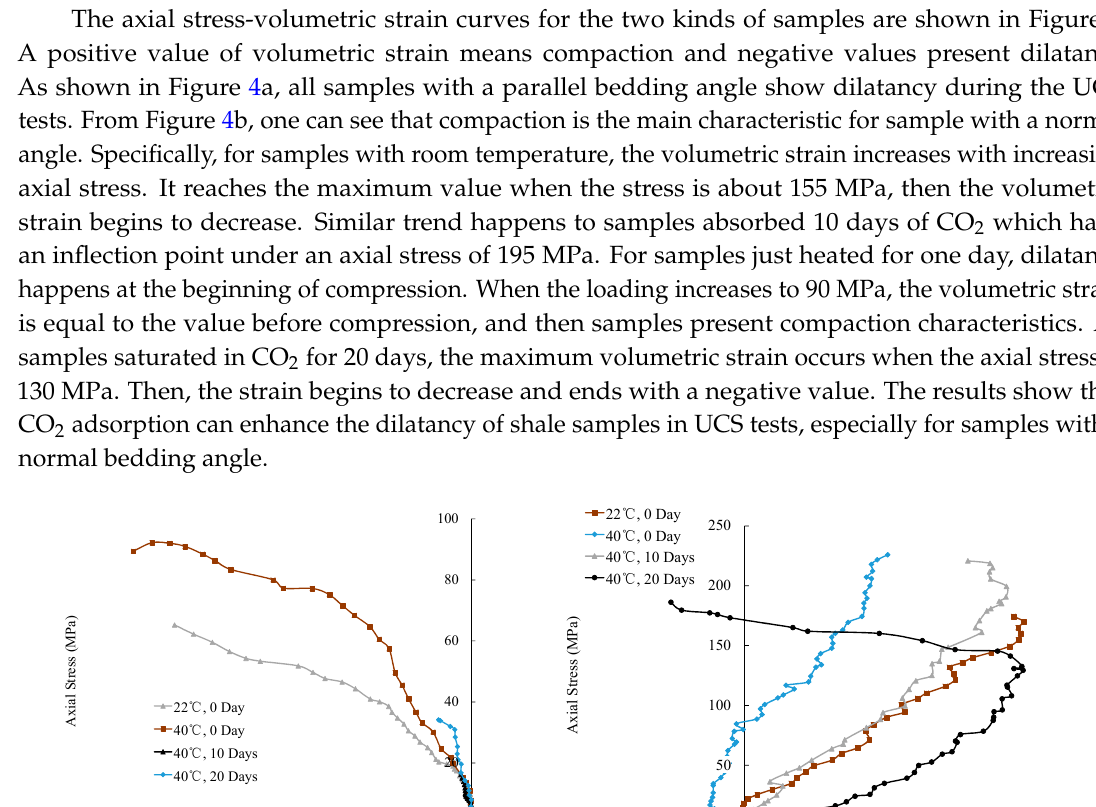
Figure 5. Determination of brittleness from a stress ‐ strain diagram.